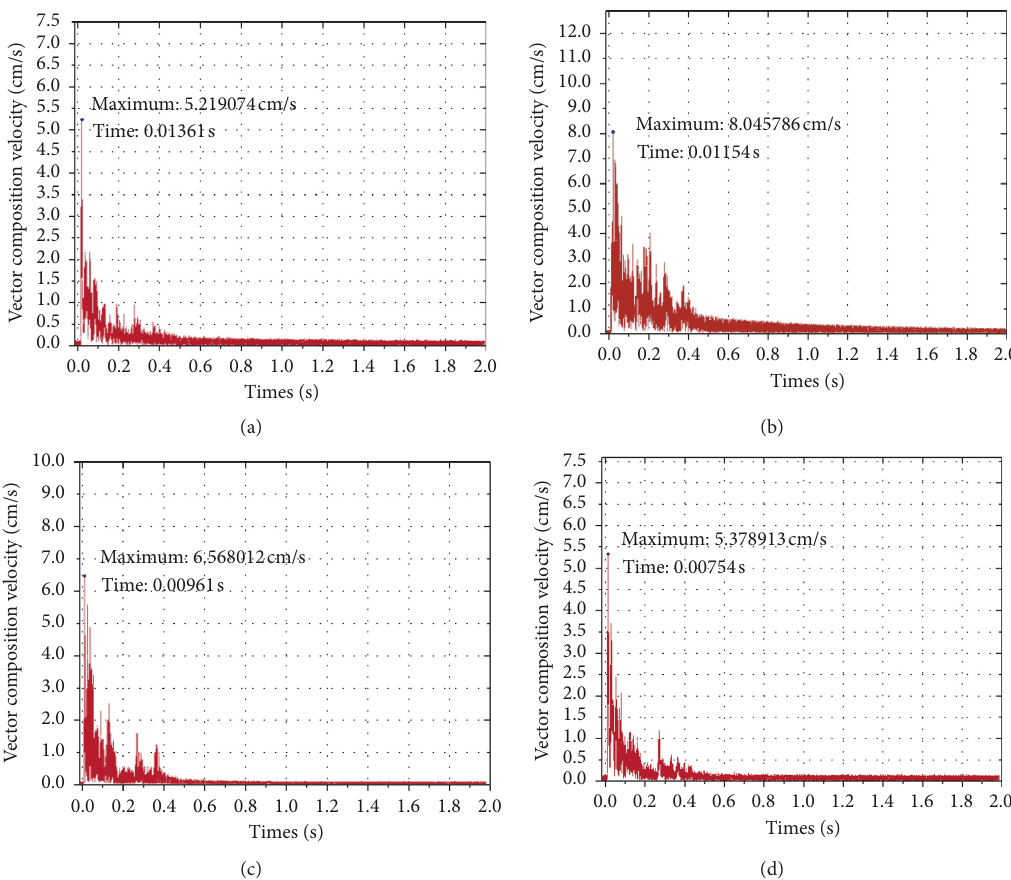
Figure 5: Time-history curve of vibration velocity at Point B during blasting of Section I (a), Section II (b), Section III (c), and Section IV